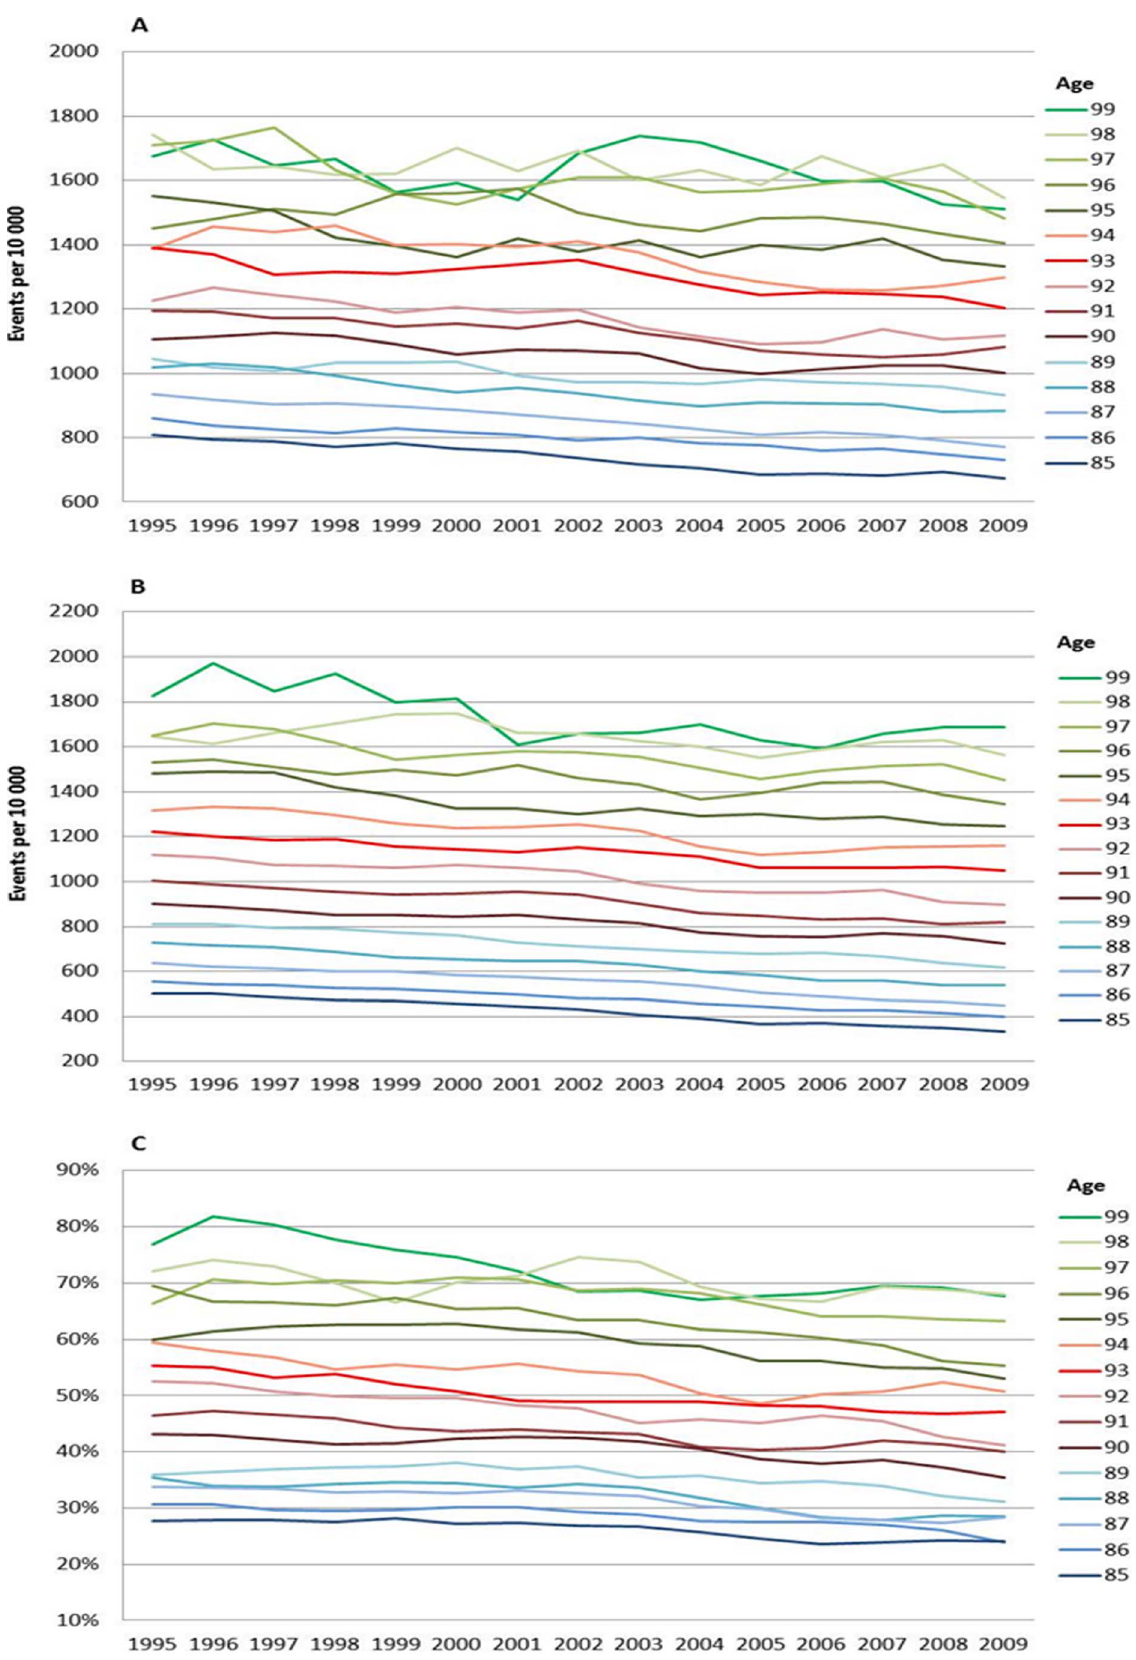
Figure 2. CVD incidence (A), mortality (B) and case fatality (C), women. Age specific trends in cardiovascular diseases, women, between 1994 and 2010. One year cumulative incidence (A), overall mortality (B), and, case fatality within 28 days, percent (C). Three year moving average. doi:10.1371/journal.pone.0064928.g002 PLOS ONE |